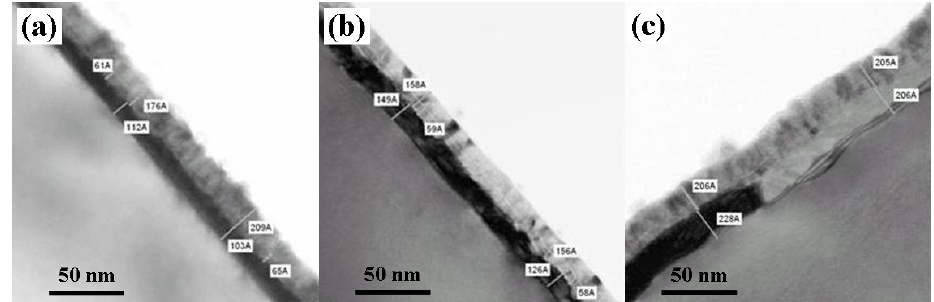
Figure 2. Cross-sectional TEM images of PECVD TiCl 4 -based Ti covered with same TiN films at